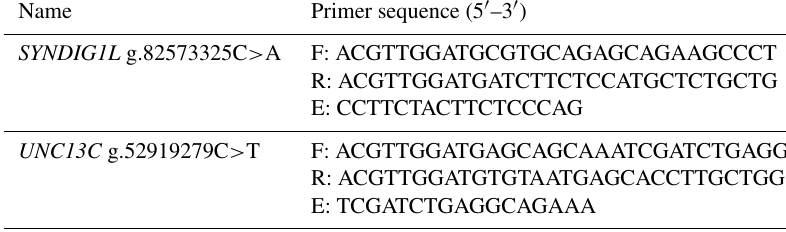
Table 3. Primer sequences for genotyping.